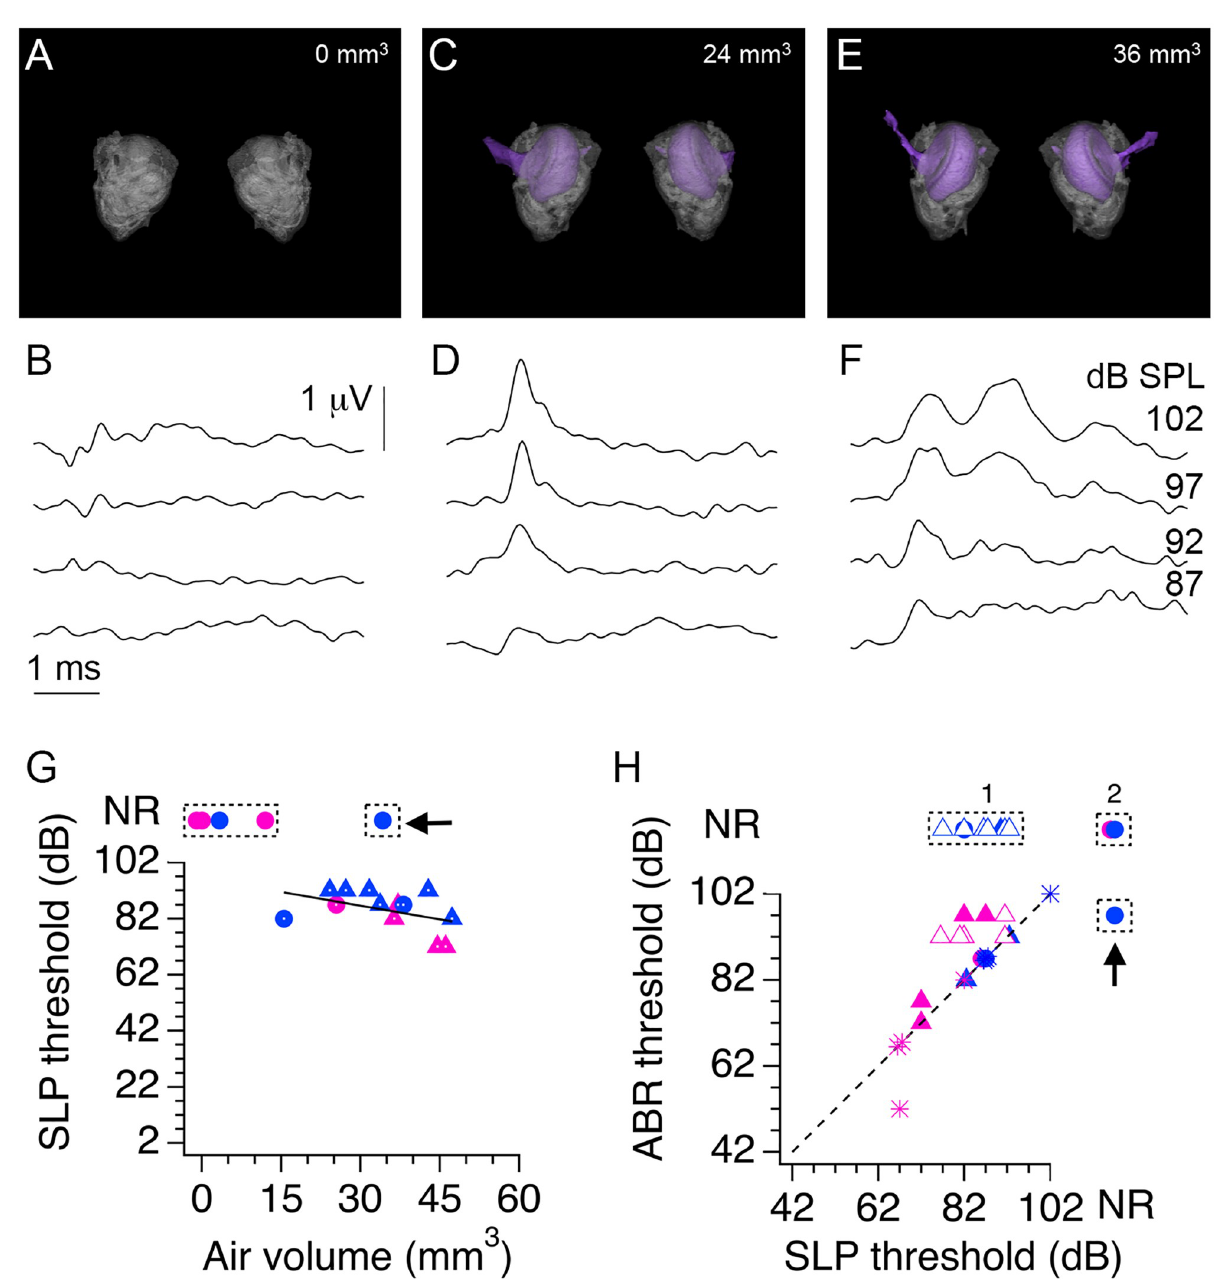
Fig 6. Identification of short latency potentials (SLPs) in combined auditory brainstem response (ABR) and micro-CT X-ray (micro-CT) experiments. A, C, E , Representative 3D renderings of three P12 pups with different volumes of air in the middle ear and external canal. B, D, F , Corresponding ABR waveforms show the presence of a SLP in pups with air volumes of 24 mm 3 and 36 mm 3 , but not in the pup without middle ear and external ear cavities. ABR traces in B, D and F correspond to click intensities shown in panel F. G , SLP thresholds as a function of air volume. Black line represents the fit to a linear function between SLP thresholds and air volume with slope 0.3 dB/mm 3 . Symbols with white dots indicate data points included in the fit. H , Comparison of SLP thresholds and wave 1 thresholds for pups measured at P12 and P13. Filled symbols represent pups used in combined ABR and micro-CT experiments. Open symbols are littermates used solely in ABR experiments at P12. Asterisks indicate pups tracked from P12 to P13. Black dashed line in H is the identity line. Arrows in G and H indicate a pup that showed an ABR wave 1 but not a SLP.